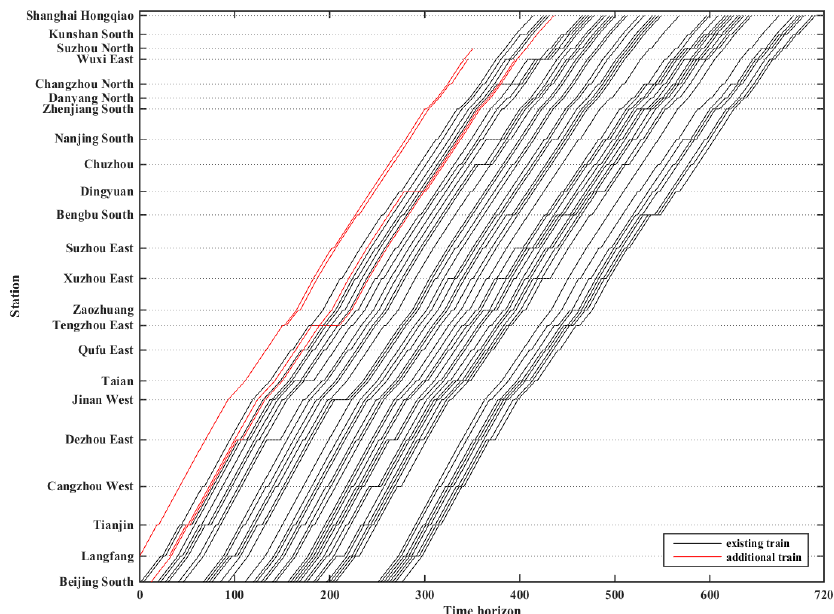
Figure 10. Timetables for existing trains and additional trains on Beijing–Shanghai railway corridor.